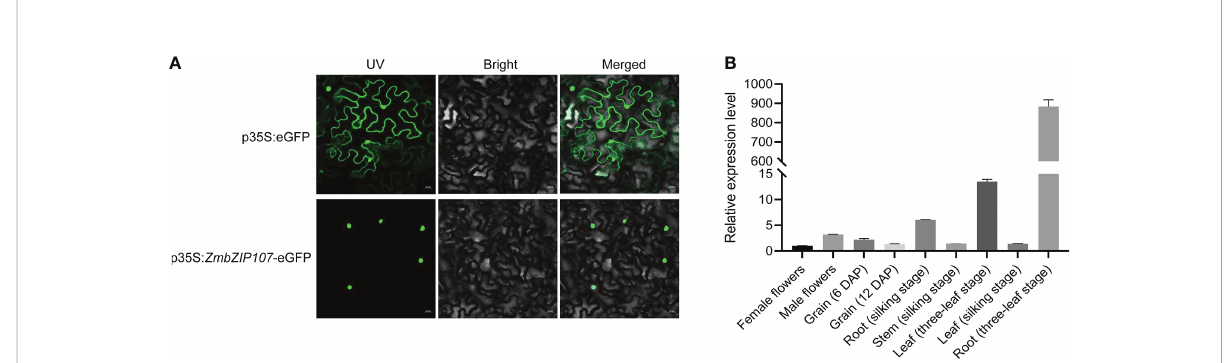
FIGURE 4 Spatial expression pattern of ZmbZIP107 . (A) Subcellular localization of the ZmbZIP107 protein in tobacco leaves. (Scale bar, 20 m m). (B) ZmbZIP107 expression level in different tissues of